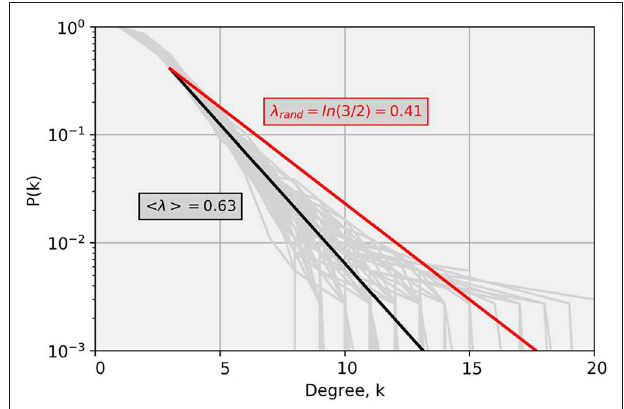
FIGURE 6 | Illustration of degree distributions for the Cedar River at Cedar Rapids. Gray lines represent degree distributions for each year (daily values), while the solid black line represents the mean exponential fit, over entire years of record. The solid red line corresponds to the degree distribution associated with a purely random process. Note that basically for all years λ is > 0.41, indicating a consistent stochastic process.